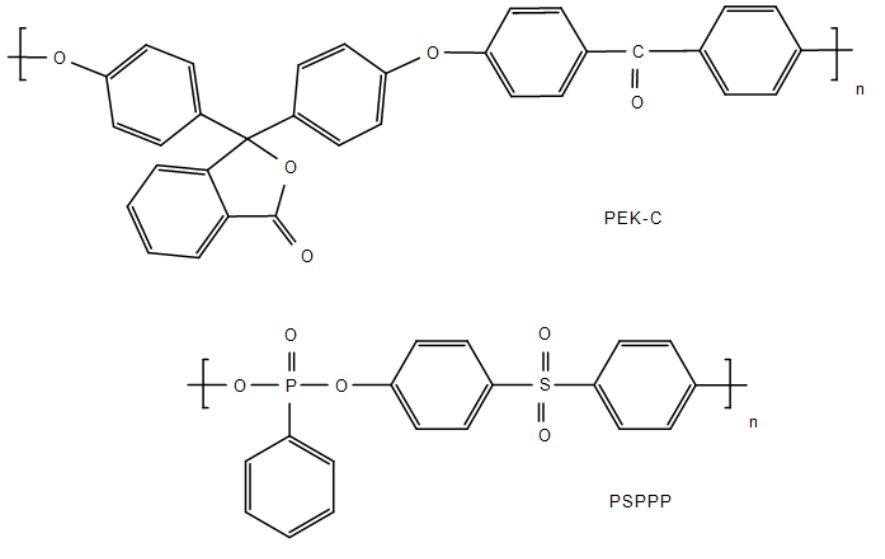
Table 1. Properties of the film interleaf and